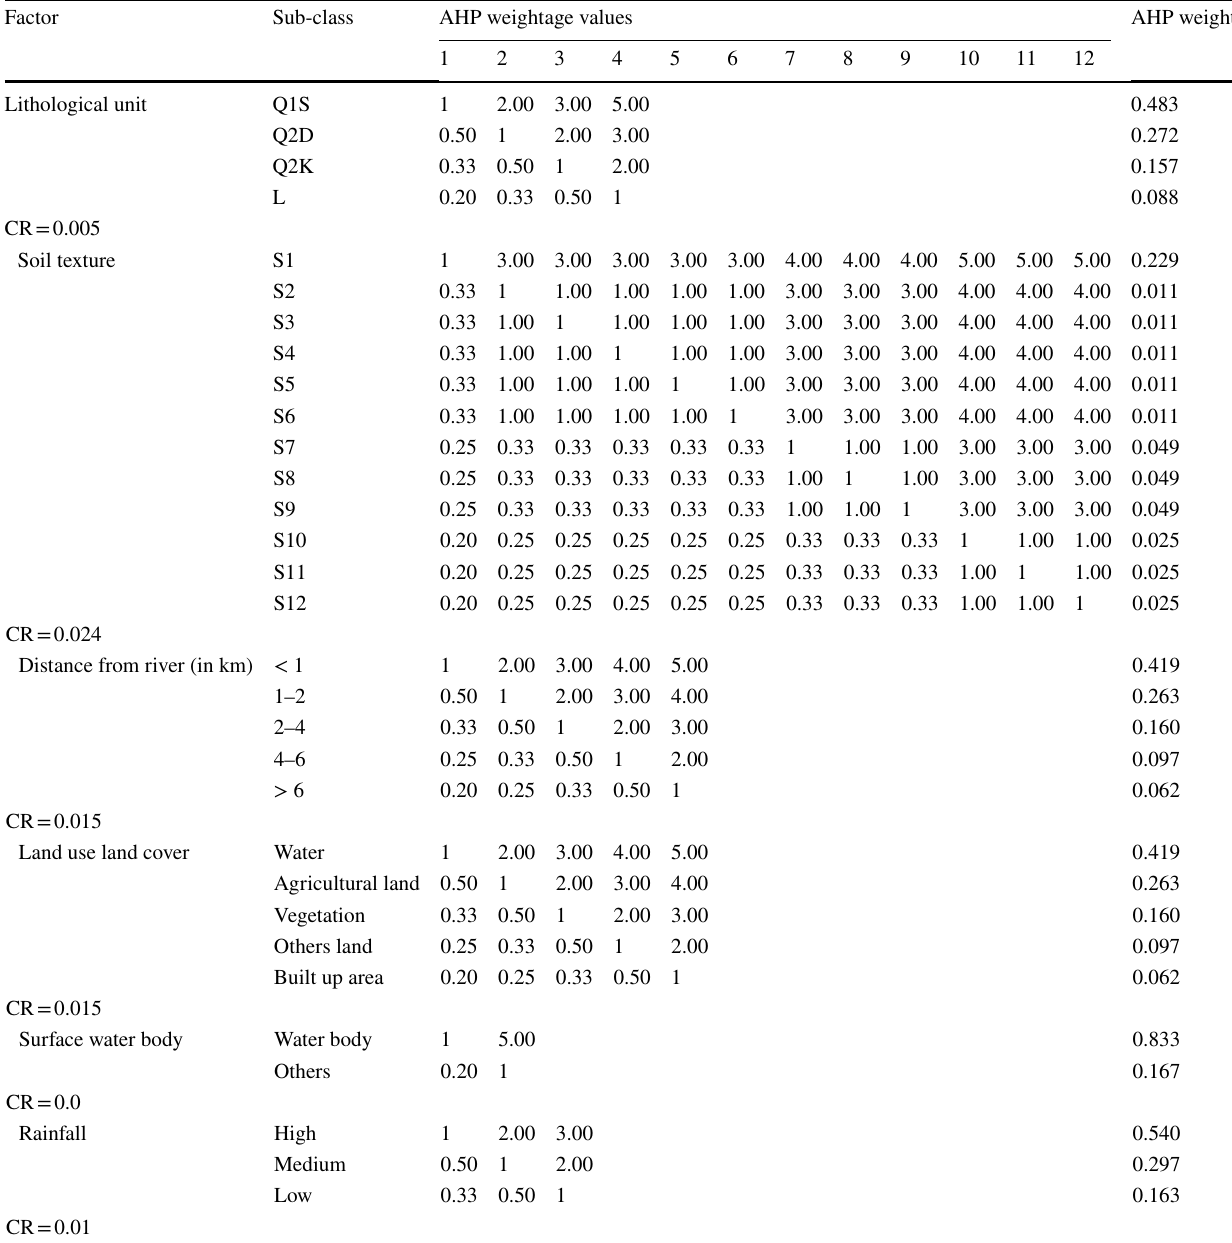
Table 5 Weightage of different parameters for groundwater potential zones mapping